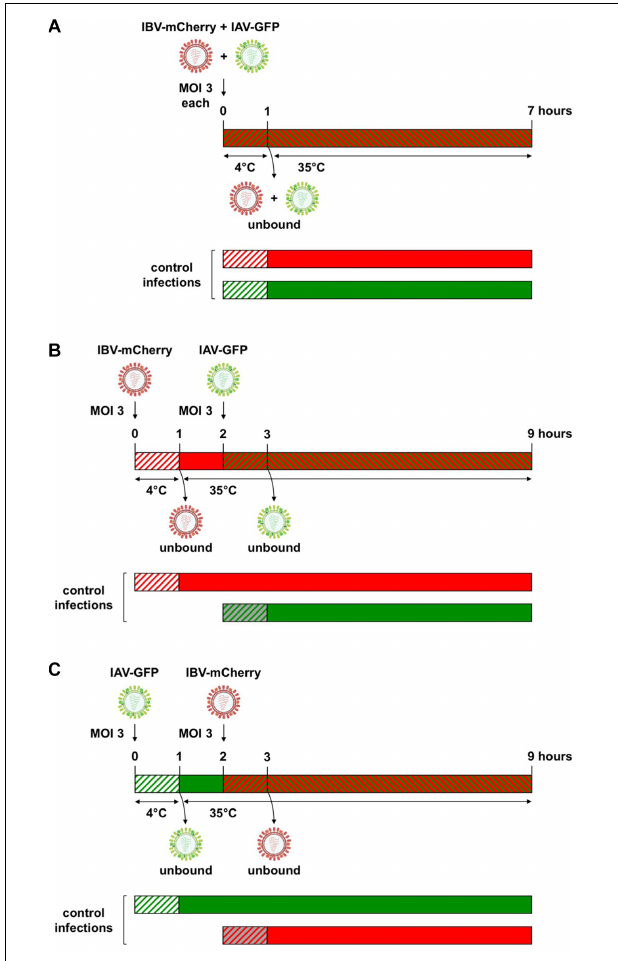
FIGURE 2 | Experimental setup for heterotypic co-infections between IAV and IBV. (A) For simultaneous co-infections, A549 cells were infected with a mixture of IAV-GFP and IBV-mCherry using a MOI of 3 for each virus. After 1 h of adsorption at 4 ◦ C, unbound viruses were removed by washing and cells were further incubated for 6 h at 35 ◦ C. For sequential co-infections, IBV-mCherry (B) or IAV-GFP (C) were first added on A549 at a MOI of 3 for 1 h at 4 ◦ C, unbound viruses were removed by washing and cells were incubated for 1 h at 35 ◦ C to allow virus entry. At 1 hpi, cells were infected at a MOI of 3 with IAV-GFP (B) or IBV-mCherry (C) . After 1 h of adsorption at 35 ◦ C, unbound viruses were removed by washing and cells were further incubated for 6 h at 35 ◦ C. Cells were then fixed and the fluorescence was measured by flow cytometry. In parallel, control infections were performed where one of the co-infecting viruses was omitted (either the first or the second one). Green and red hatched bars: IAV-GFP + IBV-mCherry; green hatched or solid bars: IAV-GFP; red hatched or solid bars: IBV-mCherry; hatched bars on white background: incubation at 4 ◦ C; hatched bars on gray or colored background and solid bars: incubation at 35 ◦ C. For IBV-mCherry, the indicated MOI refers to the stock presented in Figure 1 (MOI of 3 PFU/cell, corresponding to ∼ 5 × 10 3 physical particles/cell). For other stocks of IBV-mCherry, an amount of ∼ 5 × 10 3 physical particles/cell was used to obtain between 20 and 60% of mCherry-positive cells at 6 h post-infection.